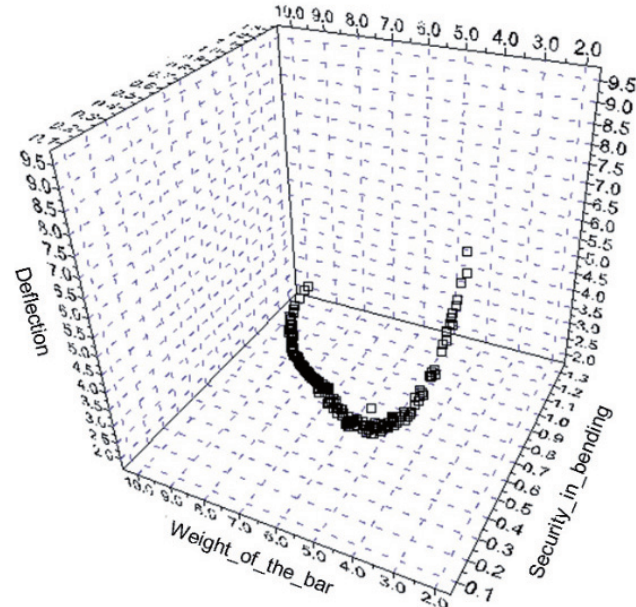
Fig. 9. Pareto domain in 3D with all functions: weight of the bar / safety in bending /